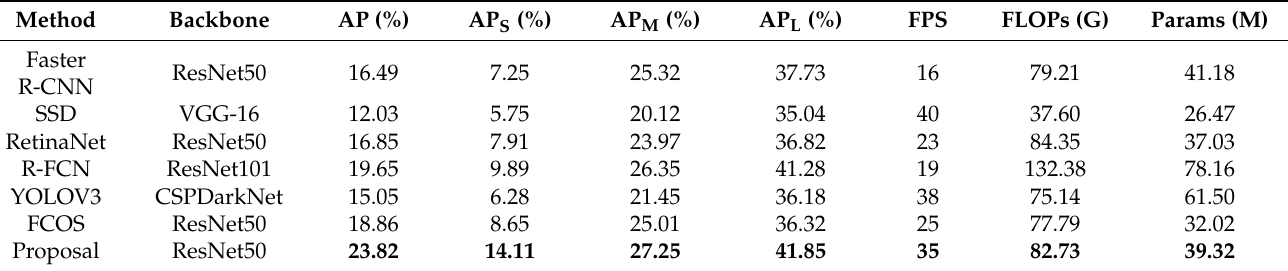
Table 2. Performance comparison of each algorithm.